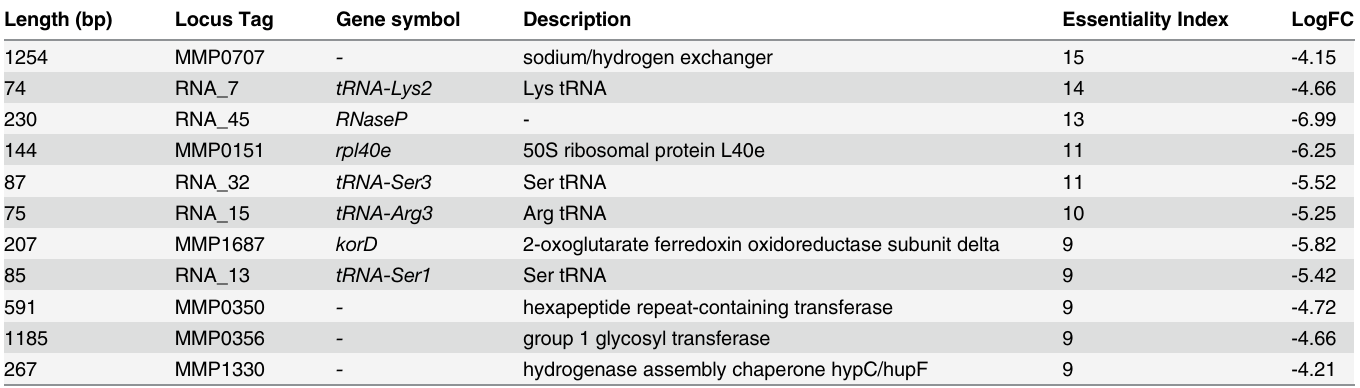
Table 2. Genes with LogFC < -4.0 (likely essential according to the ESSENTIALS results) but with EI > 8 (that is, probably non-essential by the Tn- seq